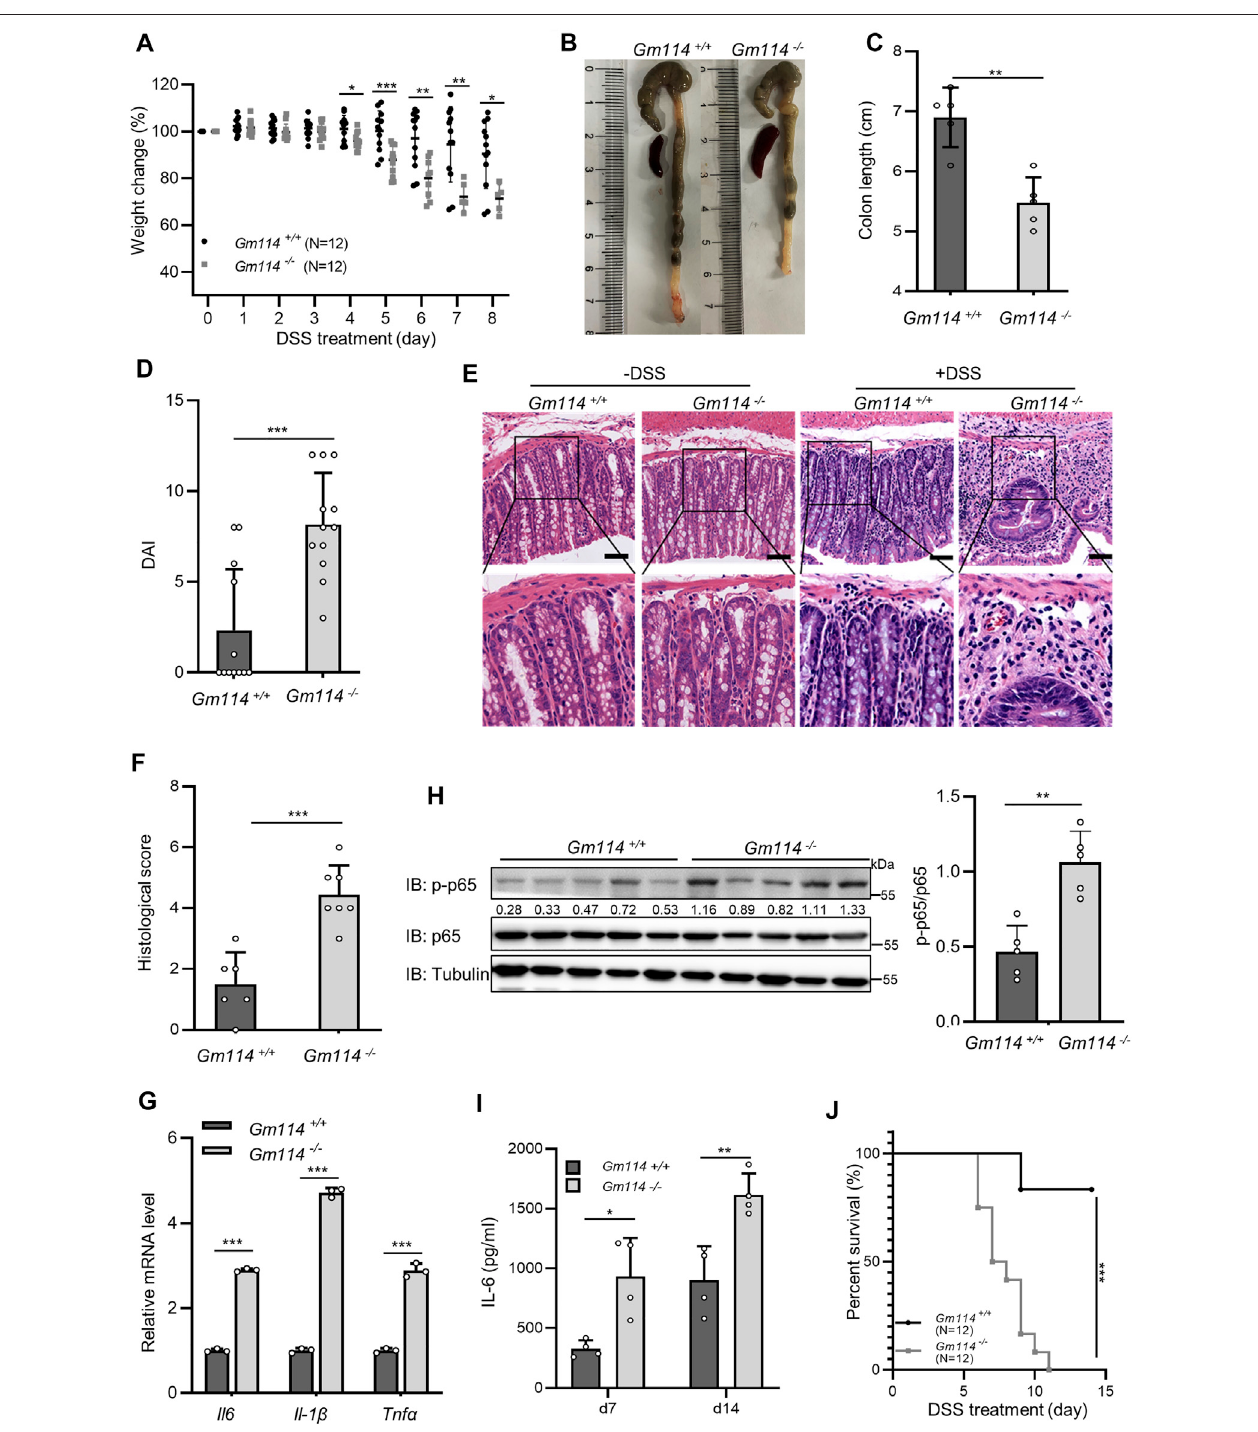
FIGURE7| GM114attenuatesDSS-inducedacutecolitis. (A) Gm114 +/+ and Gm114 − / − miceweretreatedwith5%(w/v)DSSindrinkingwaterfor5 days,followed by 9 days of normal drinking water. Body weight changes were recorded daily until the mice had mostly died (day 8). Data represent the weight change relative to each individual starting weight. (B,C) Gm114 +/+ and Gm114 − / − mice were treated with 2.5% (w/v) DSS in drinking water for 7 days, followed by 7 days of normal drinking water.Miceweresacri fi cedonday14tomeasurethecolonlength. (D) Miceweretreatedasdescribedin (A) .CompositeDAIscoresweredeterminedbyassessing weight loss, stool consistency, and the presence of blood in stool and/or the rectum at day 5 after DSS treatment. (E,F) Mice were treated as described in (B) . Representative H&E-stained sections of colons from mock- and DSS-treated Gm114 +/+ and Gm114 − / − mice (14 days). Scale bar represents 50 μ m (E) . Histological